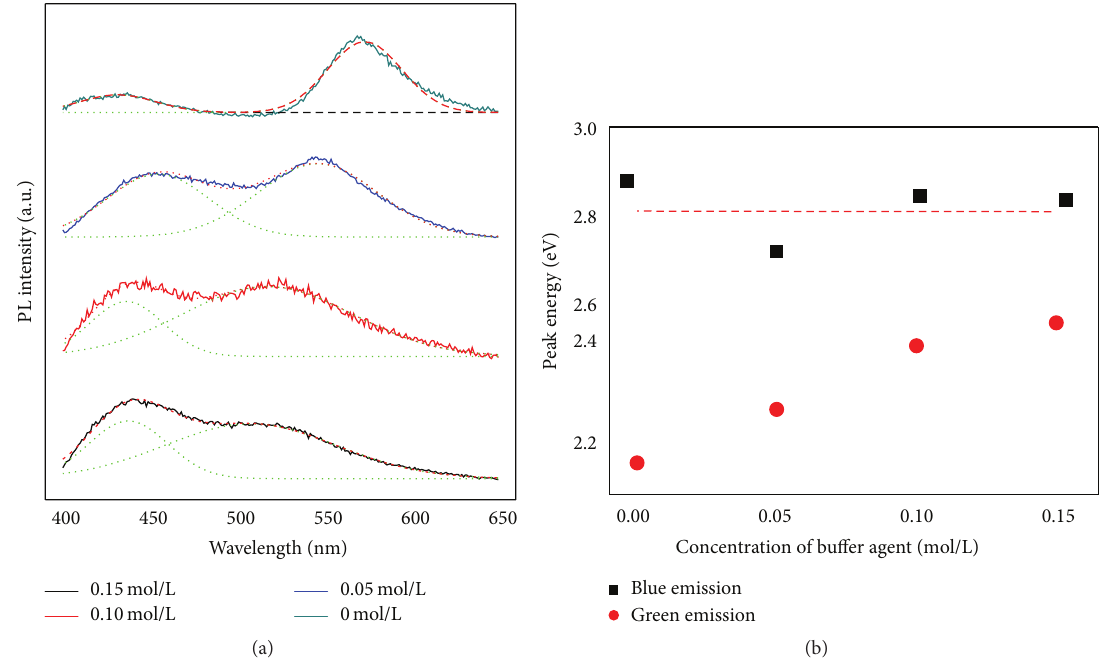
Figure 4: (a) Photoluminescence of CdS/Si-NPA, (b) peak energy of blue and green emissions.